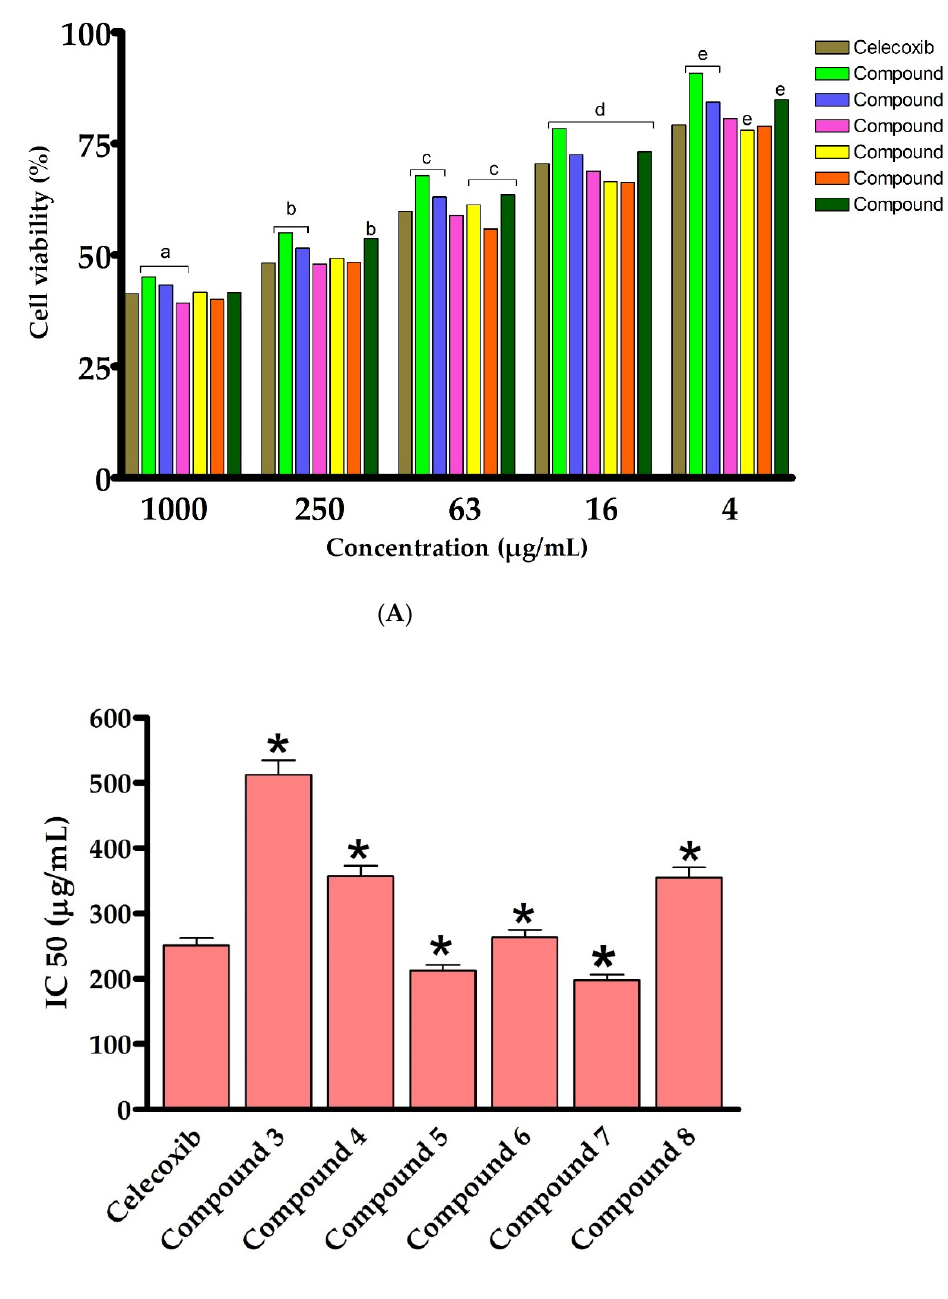
Figure 4. In vitro cytotoxic effect of 2-thioxoimidazolidin-4-one derivatives ( 3 – 8 ) against murine cell line (RAW264.7). ( A ): cell viability of celecoxib and compounds 3–8 at different concentrations. ( B ): IC 50 (µg/mL) against RAW264.7. Data are shown as mean ± SD. a p < 0.05 versus celecoxib at concen- tration of 1000 µg/mL, b p < 0.05 versus celecoxib at concentration of 250 µg/mL, c p < 0.05 versus celecoxib at concentration of 63 µg/mL, d p < 0.05 versus celecoxib at concentration of 16 µg/mL, e p < 0.05 versus celecoxib at concentration of 4 µg/mL and * p < 0.05 versus celecoxib.